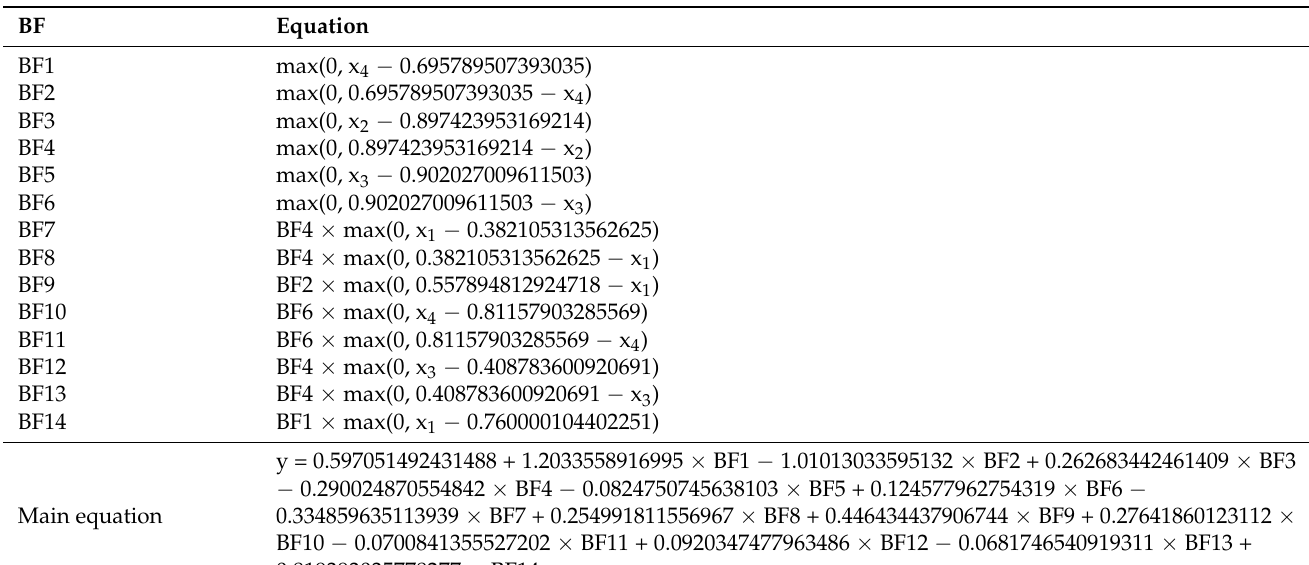
Table 3. Basis Functions for